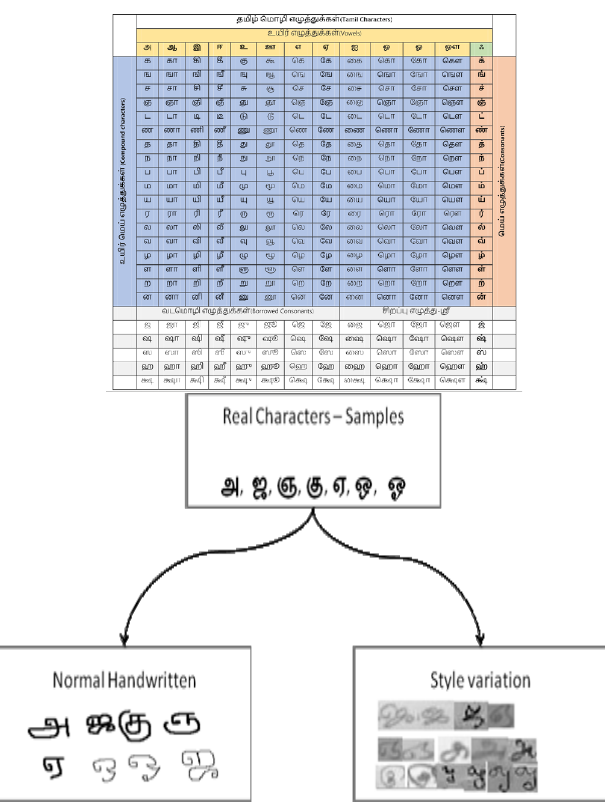
Figure 2. Character Sample at Various Levels